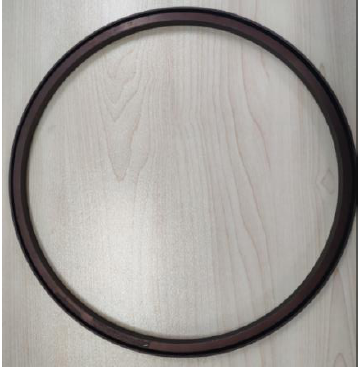
Figure 8. Photos of the three new isolators. Table 2. Material parameters of the isolators.